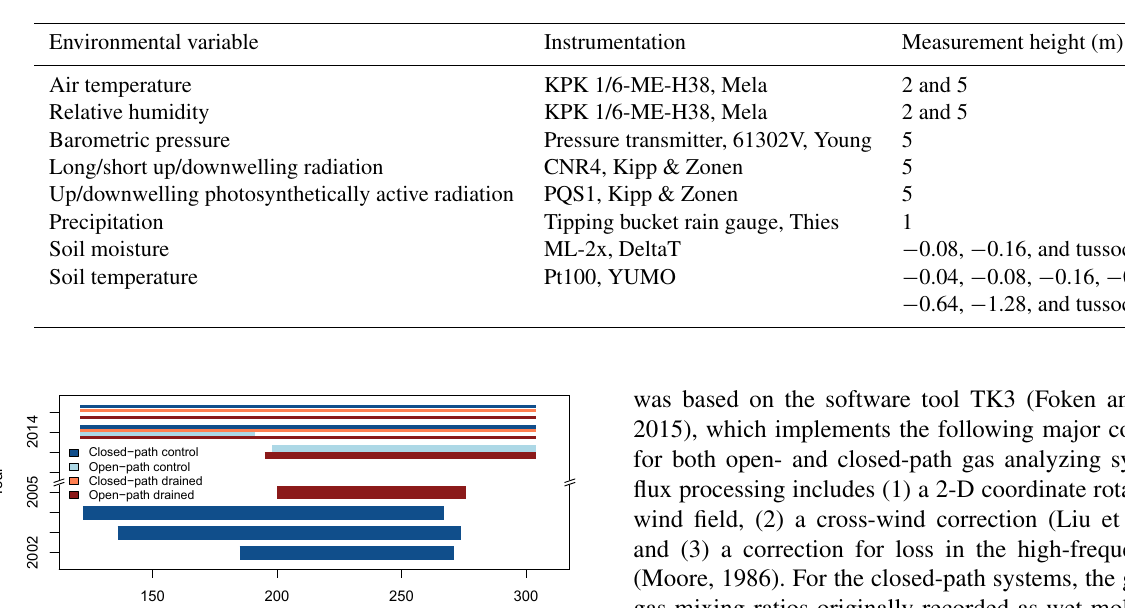
Table 1. Summary of the observed environmental variables available for both towers, including instrumentation and measurement height. Tussock measurements describe the conditions in the middle of the tussock (0.2m to the top of the tussock and 0.2m to the soil surface). Heights above the soil surface are indicated as positive numbers; depths below the soil surface are given as negative numbers.